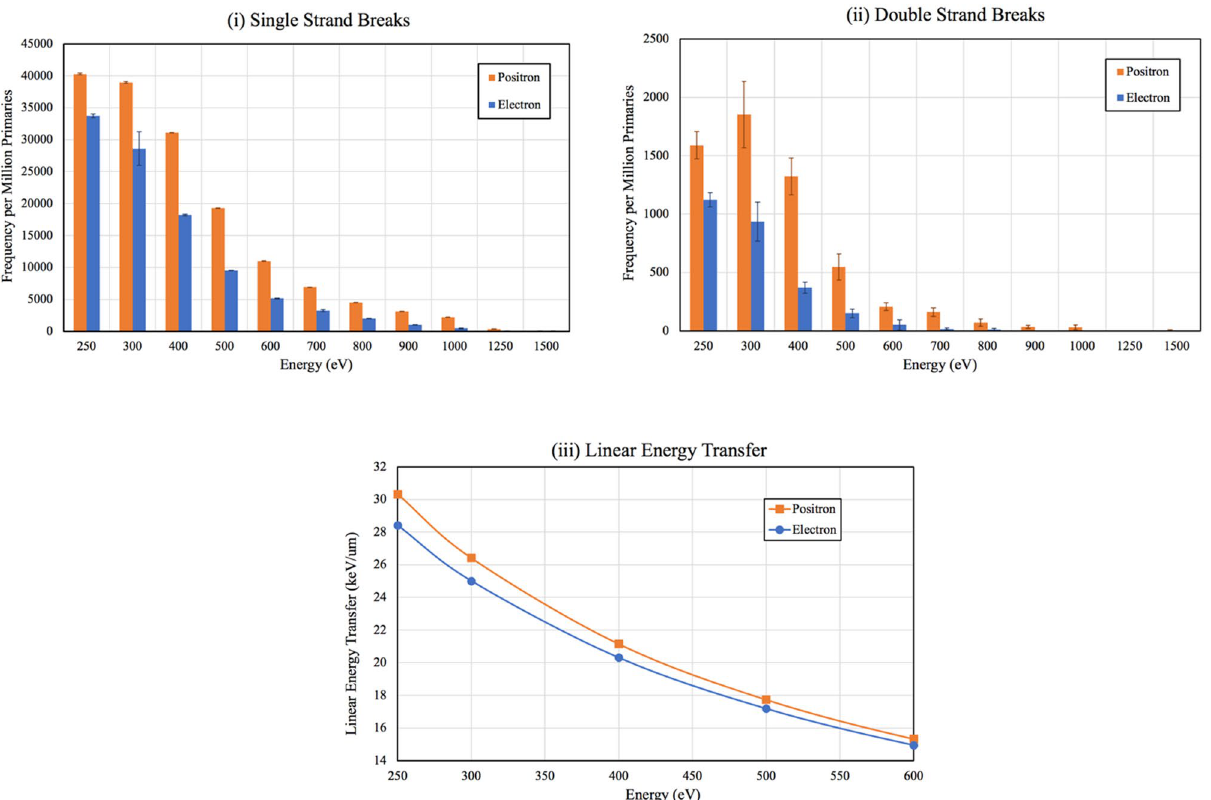
Figure 3. (i) SSB frequency and (ii) DSB frequency for β + and electrons from the TOPAS-nBio simulation. The highest difference in the frequency between β + and electrons occurred at 400 eV. (iii) Plot of the primary β + and electron LET (keV/μm) across the simulated